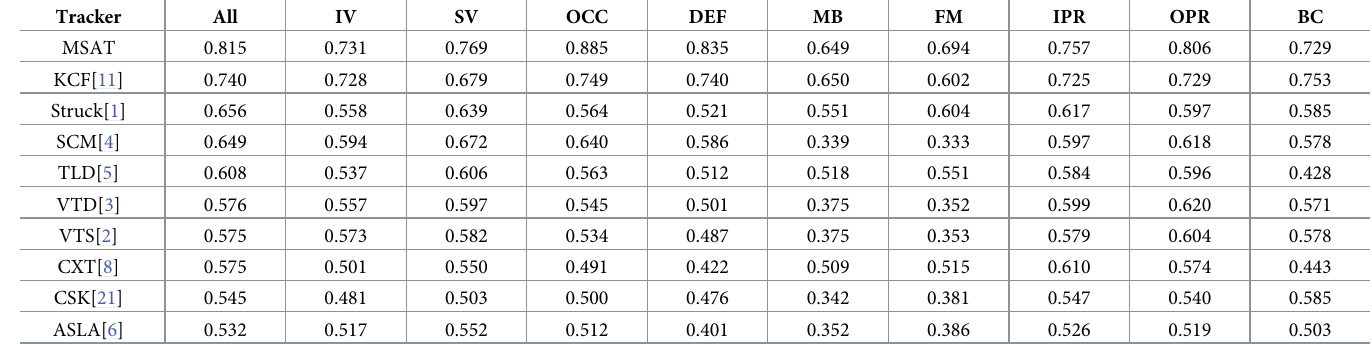
Table 2. Mean OP score on the visual tracker benchmark dataset and its challenging sub-categories for the top ten tracking algorithms[1,2,3,4,5,21,11,8,7,6]. Red and blue label mean the best and second scores, respectively. Tracker